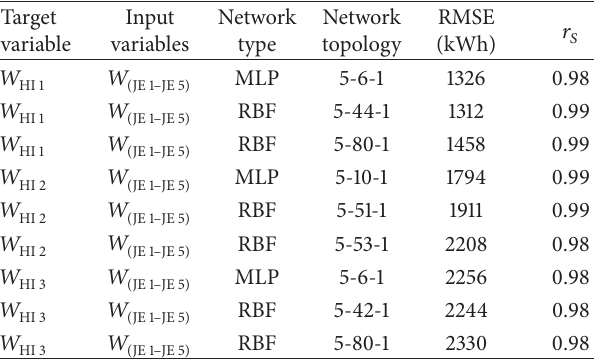
Table 3: Summary of results for the energy output of the target turbines at the coastal site Hinte